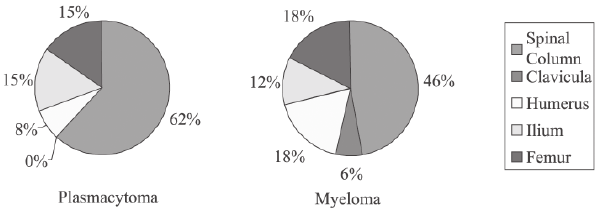
Figure 7 - Anatomic location of primary tumors in patients with plasmacytoma and in patients with plasmacytoma that progressed to multiple myeloma (absolute and relative (%) frequency distribution)